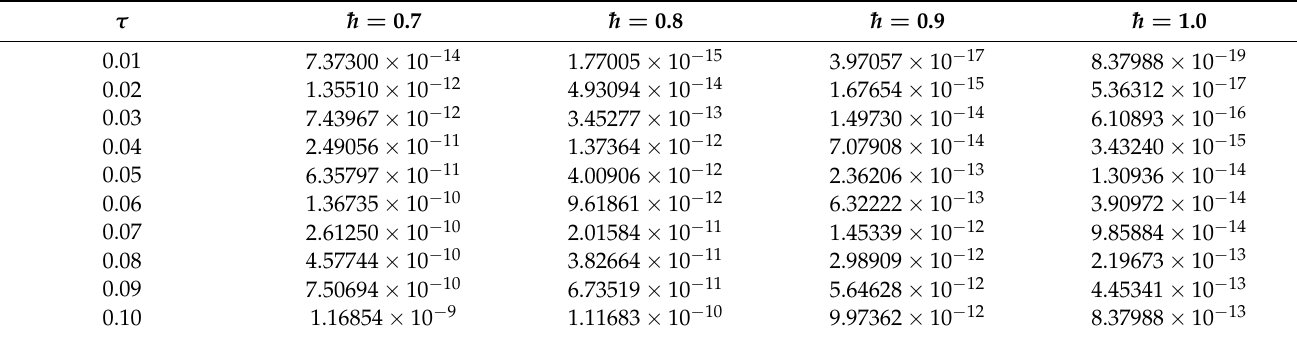
Figure 3. In Figure 3, the 3D curve of the | Ω ( α , τ ) − Ω 5 ( α , τ ) | in the ranges τ ∈ [ 0, 0.2 ] and α ∈ [ 0, 0.2 ] , when ¯ h = 1.0 for ( a ): Problem 1; ( b ): Problem 2; ( c ): Problem 3, when ξ = 2.0. Table 3. The | Ω 6 ( α , τ ) − Ω 5 ( α , τ ) | of Problem 1 at varying values of ¯ h at α = 0.002 determined by the ARPSM at plausible locations in the range τ ∈ [ 0, 0.10 ]